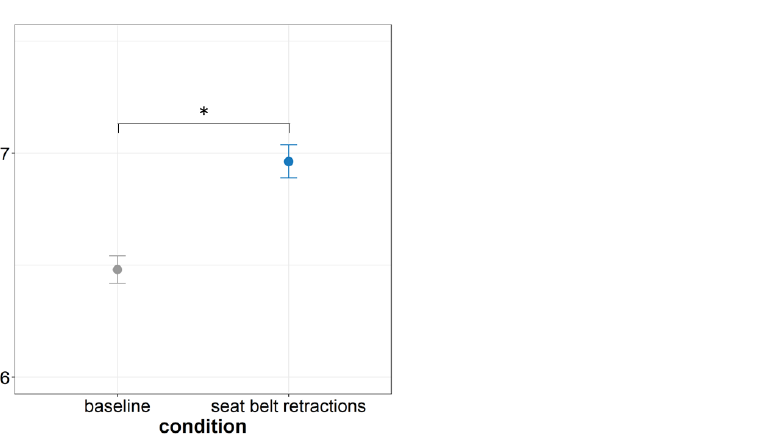
Figure 14. Means of maximum and minimum relative head angles grouped by seat belt condition; ( a ) Maximum relative head angle; ( b ) Minimum relative head angle. Error bars display 95% confidence intervals. *** p < 0.001.